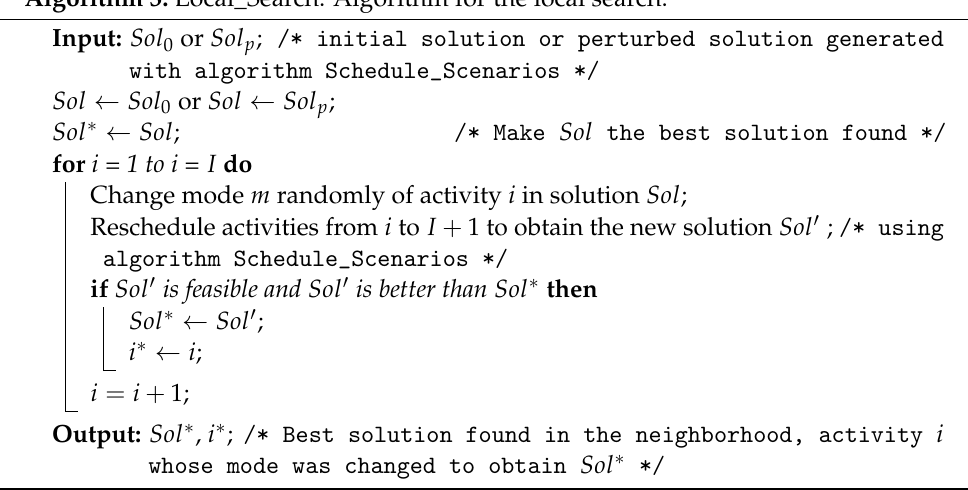
Algorithm 3: Local_Search. Algorithm for the local